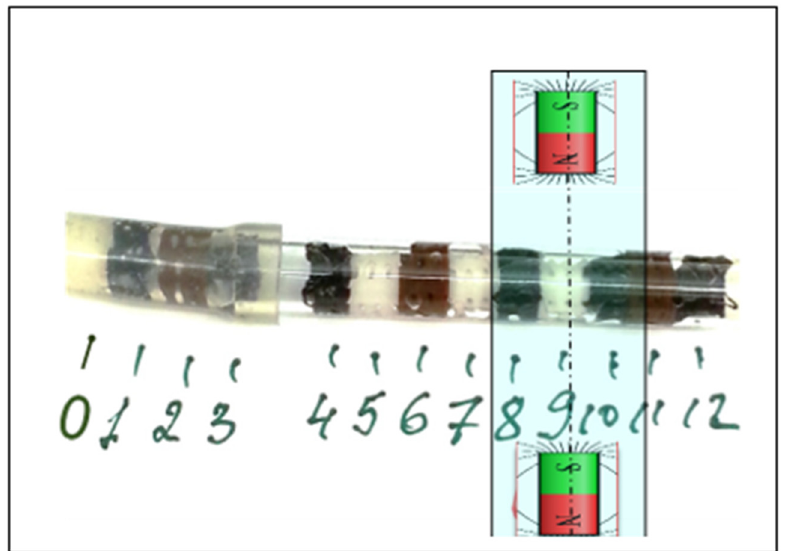
Figure 1. Experimental setup for cell seeding in the array of 13 scaffolds, numbered following their position. The scaffolds color corresponds to their magnetization: black for PCL-HAp-1%SPION, brown for PCL-HAp-0.5%SPION, and white for PCL-HAp.